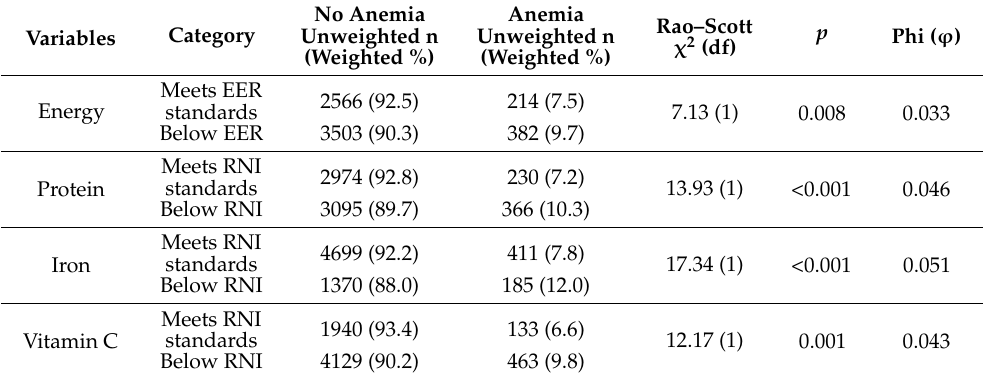
Table 2. Anemia status according to estimated energy requirements (EER) and recommended nutrient intake (RNI).